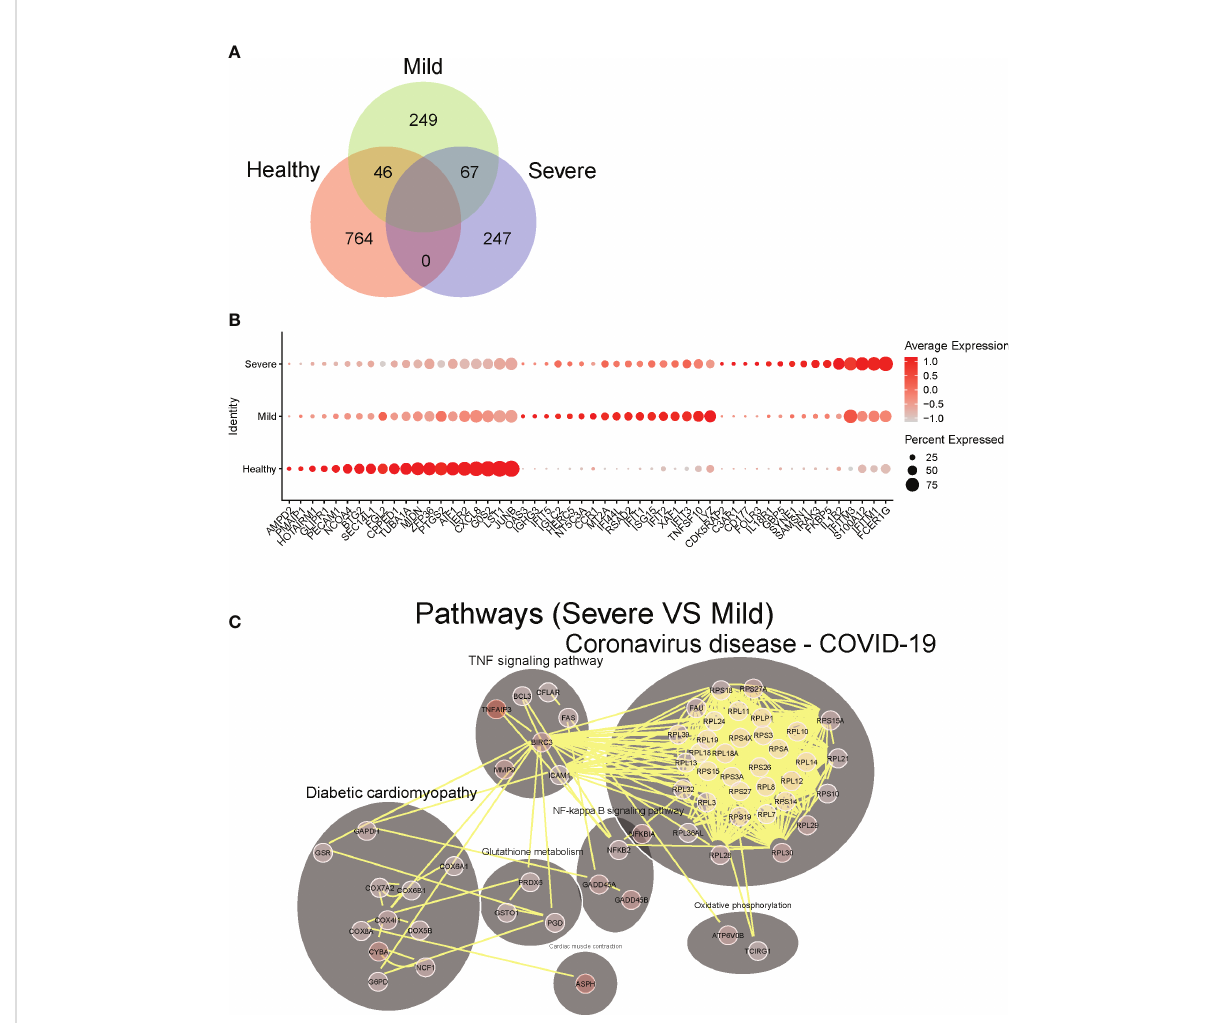
FIGURE 2 Identi fi cation of dysregulated neutrophil phenotypes in severe COVID-19 patients. (A) Venn plot of signi fi cantly up-regulated genes (adjusted P- value <0.05) in neutrophils from healthy controls, mild and severe COVID19 patients. (B) Top 10 differentially expressed upregulated genes in neutrophils from healthy controls, mild and severe COVID19 patients, respectively. (C) Predicted cell-cell interaction networks of signi fi cantly up-regulated pathways (adjusted P-value <0.05) in neutrophils from severe COVID19 patients compared with that from the mild